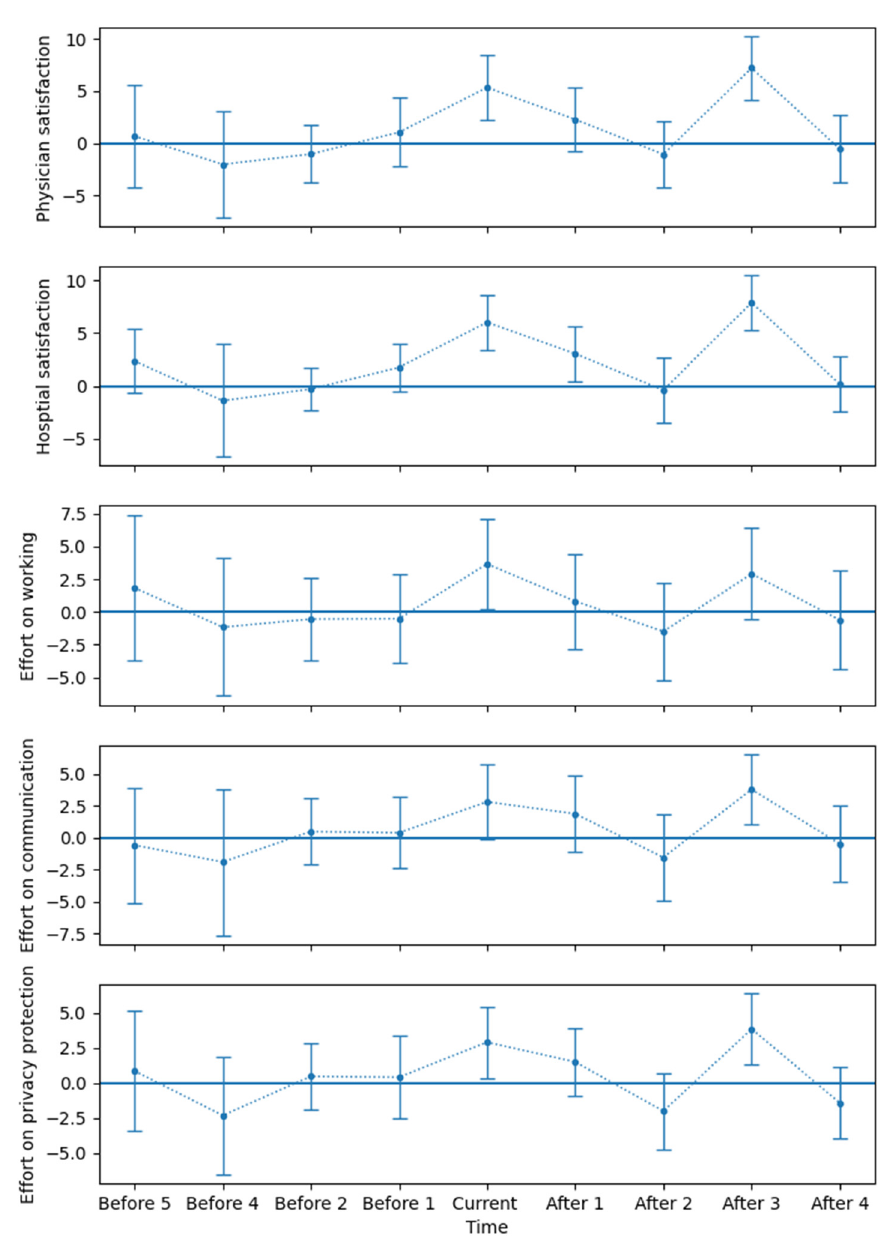
Figure 2. The event-study approach for the effects on physician satisfaction; hospital satisfaction; and efforts in working, commutation and privacy protection. The upper and lower bounds of the error bars are 95% confidence intervals with cluster-robust standard errors clustered by department.